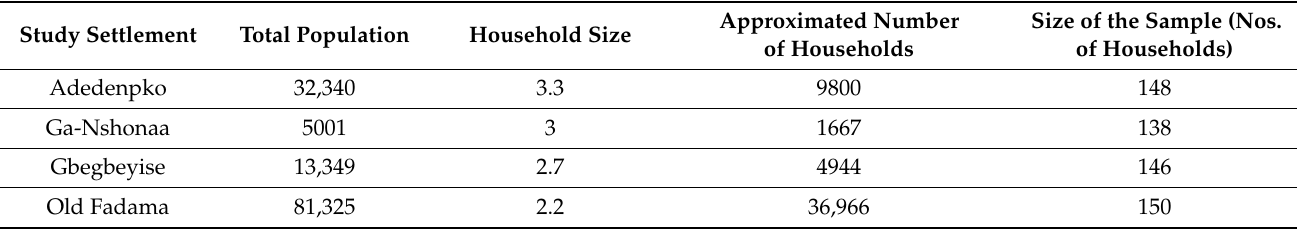
Table 1. Sample Population of the Case Study